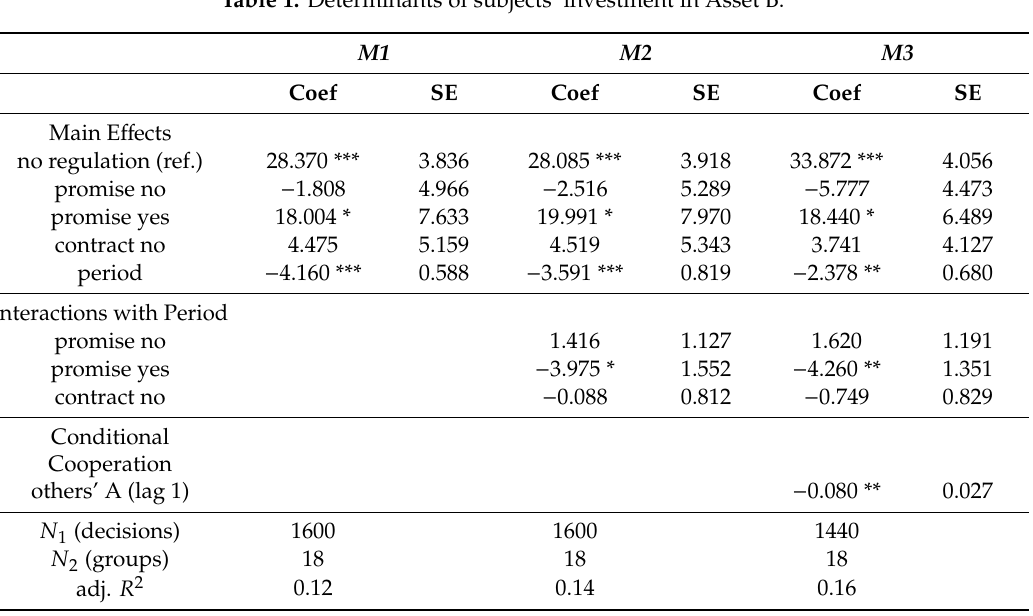
Figure 2. Mean investment in Asset B over time. Table 1. Determinants of subjects’ investment in Asset